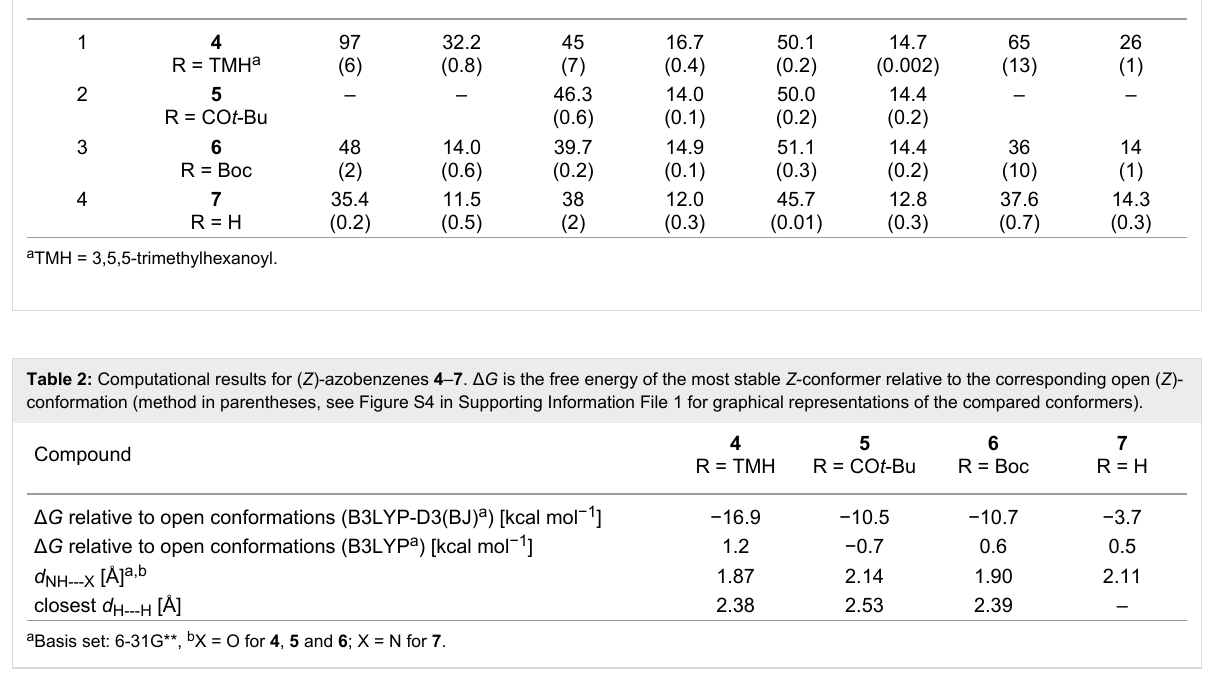
Table 1: Thermal Z → E isomerization half-lives τ (standard deviations in parentheses) of azobenzenes 4 – 7 in various solvents.